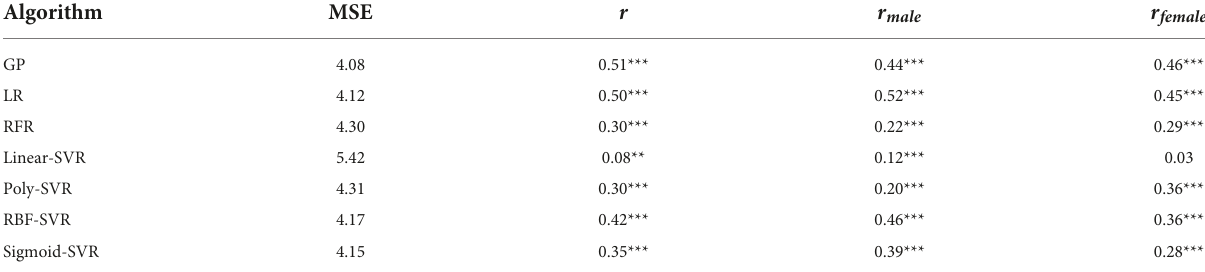
TABLE 4 The mean squared error and the correlations between the model-predicted scores and the self-reported self-esteem scores.